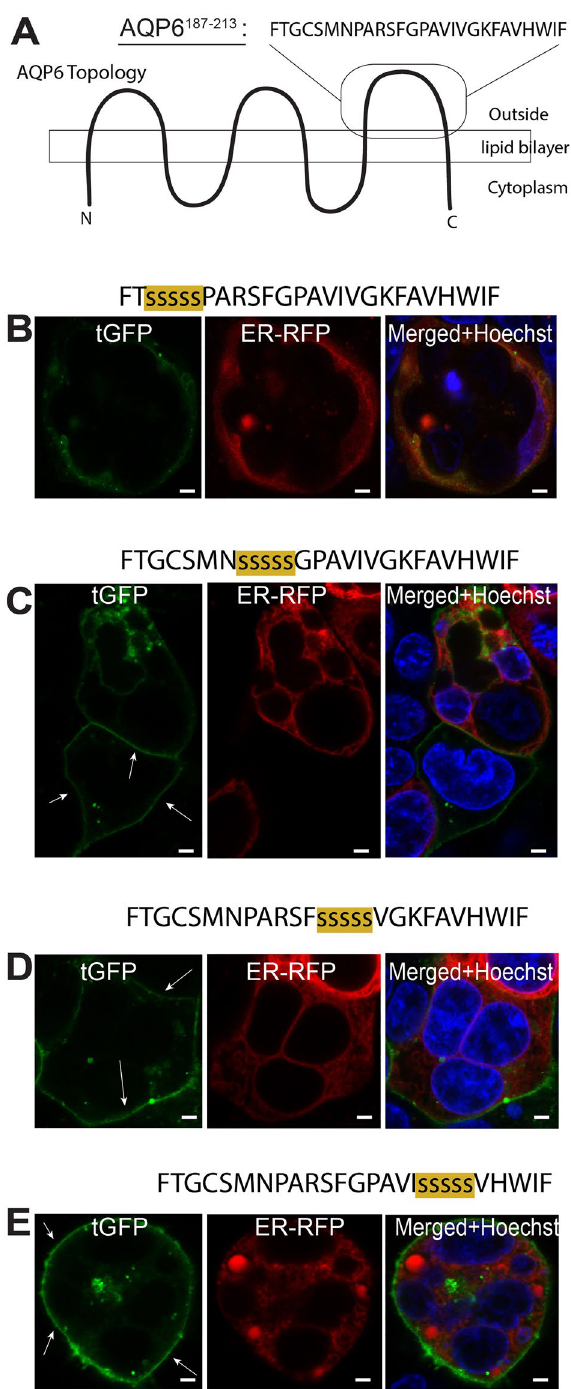
Figure 4. Serine mutagenesis pinpoints Omega signal localization. ( A ) The amino acid sequence comprising peptide fragment AQP6 187–213 is shown. ( B ) When this peptide fragment was substituted with 5 serine substitutions and C-terminally attached to AGR, this construct fails to localize to the PM of HEK293 cells. In contrast, ( C – E ) amino acid serine substitutions within the indicated peptide fragments and then C-terminally attached to AGR, these constructs localize in the PM of HEK293 cells (white arrows). Cells were observed microscopically using an upright Olympus BX51WI equipped with 100 × 1 NA objective and images were captured using a Grasshopper3 CMOS camera (FLIR, Richmond, BC, Canada) controlled by Leica LAS X version 3.5 software (available at: https:// www. leica- micro syste ms. com/ produ cts/ micro scope- softw are/p/ leica- las-x- ls/). All figures were created using Adobe Illustrator CS6 (Available at: https:// adobe. com/ produ cts/ illus trator), under an Adobe Inc., Creative Cloud Desktop 2019 shared device license to Case Western Reserve University (CWRU) that operates until 3/31/2022. Scale bars: 8